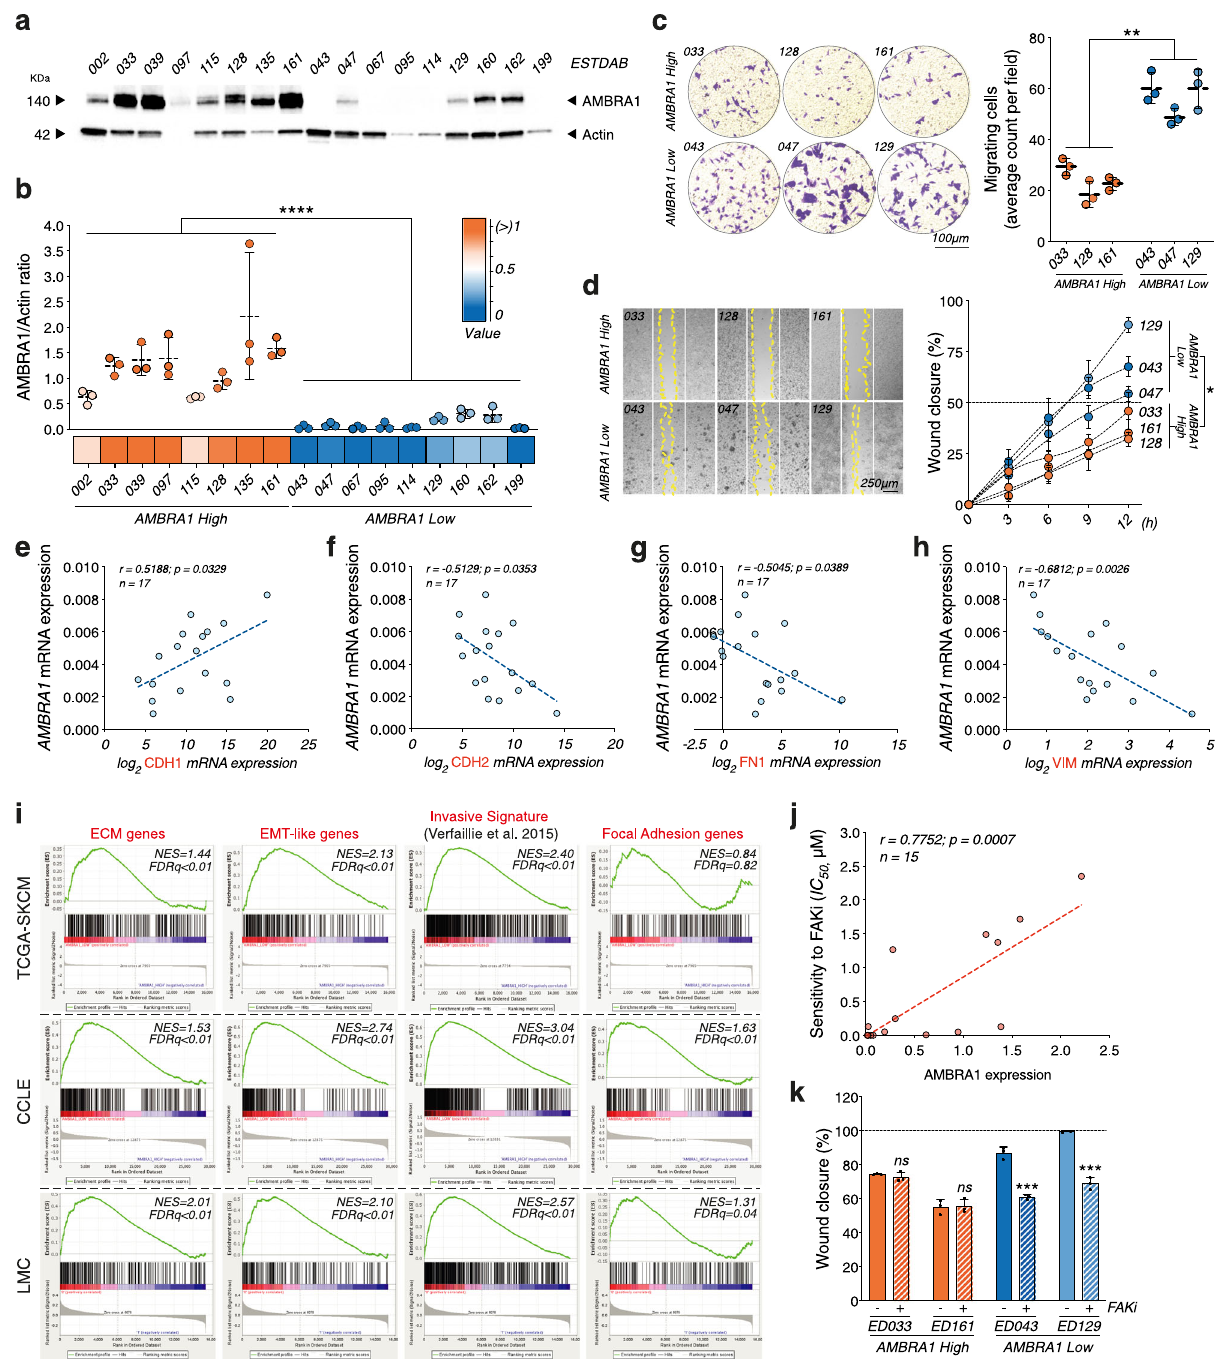
de fi cient melanocytes and melanoma to both c-Myc